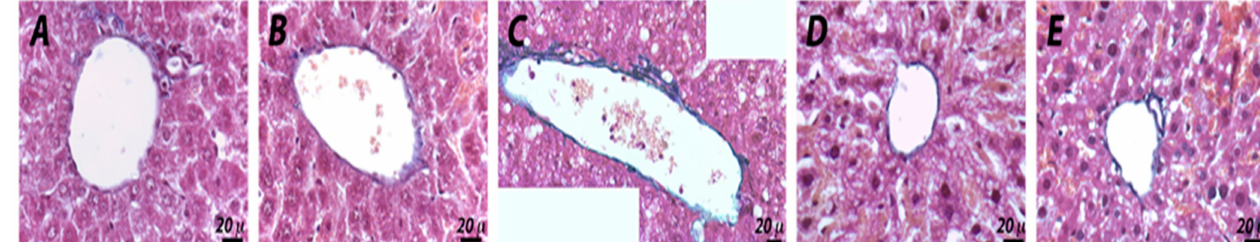
Figure 9. Histological observations of different treatments in mouse livers. Masson staining ( A – E ). In untreated and vehicle ( A , B ) samples, the regular presence of blue stained collagen fibers is observed. Indomethacin ( C ) samples show an increase in the collagen fibers below the endothelium of the portal and the central vein. In ketorolac ( D ) and ketogal ( E ) samples, no sign of fibrosis can be